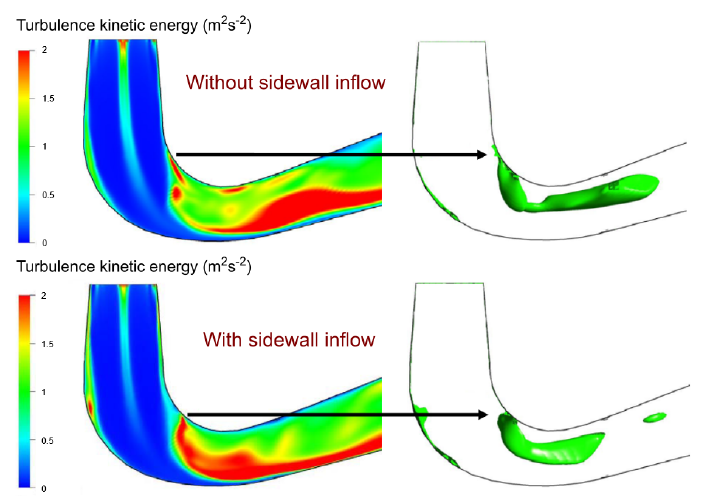
Figure 12. Discrepancies in turbulent kinetic energy and recirculating zones in draft tube of Francis turbine